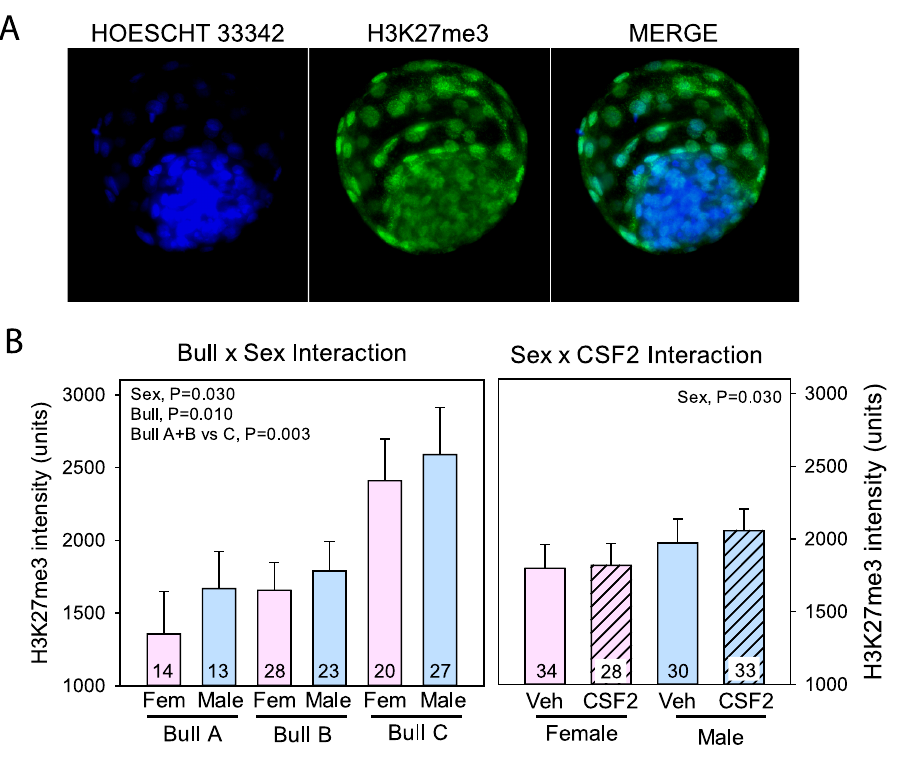
Fig 3. Immunolabeling for H3K27me3. A. Representative example of labeling of a blastocyst using antibody to H3K27me3. B. Least-squares means ± SEM of fluorescent intensity of H3K27me3 in nuclei of TE cells as affected by sex, bull, and CSF2 and after using labeling for H3 as a